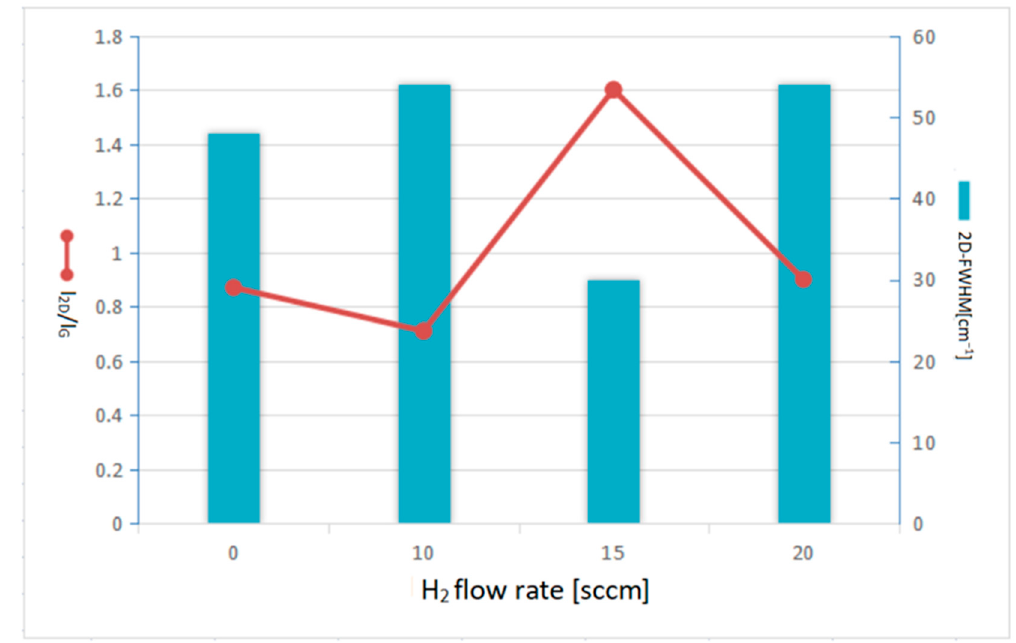
Figure 5. Relations of I 2D /I G ratio and 2D-FWHM value of peaks in Raman spectra corresponding to the hydrogen gas flows rate of 0, 10, 15, 20 sccm, respectively.